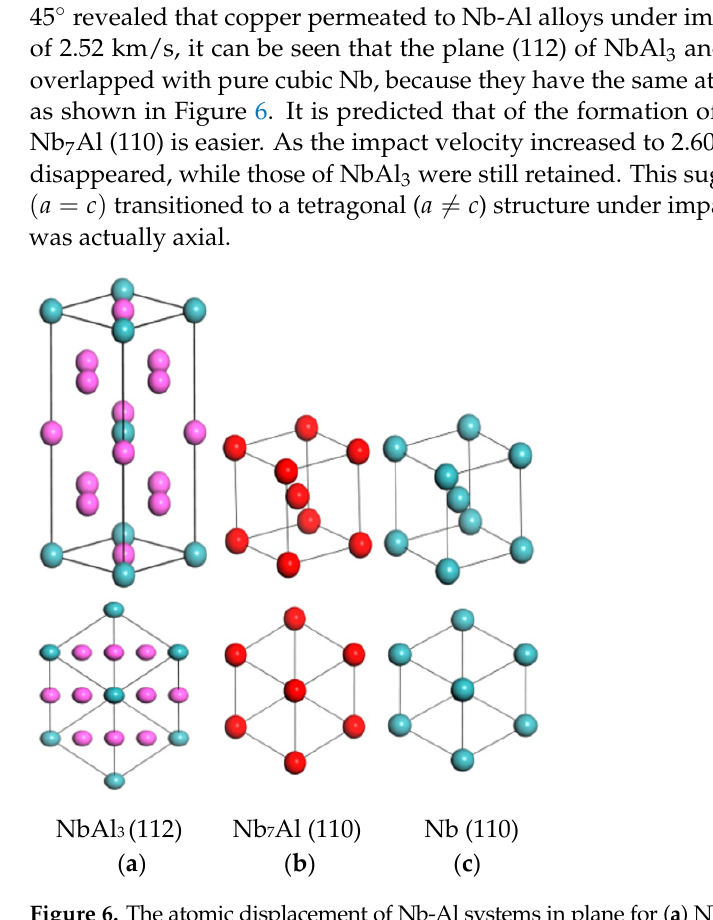
Figure 6. The atomic displacement of Nb-Al systems in plane for ( a ) NbAl 3 (112), ( b ) Nb 7 Al (110) and ( c ) Nb (110), where the light blue is Nb, the purple is Al and the red consists of 1.725 Nb and 0.25 Al.